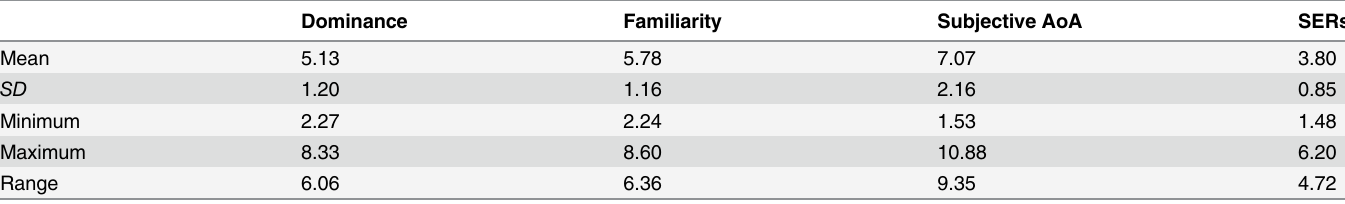
Table 1. Descriptive stimulus